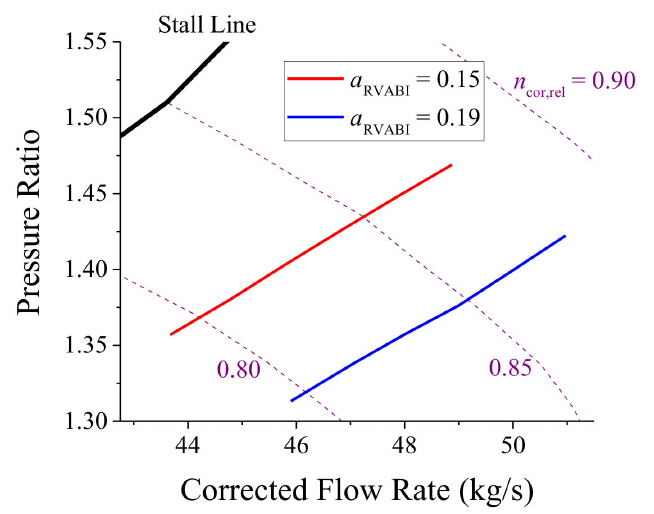
Figure 33. The Variations of the Matched Operating Lines of AFS at the conditions of Different Area Coefficients of RVABI ( α RVABI